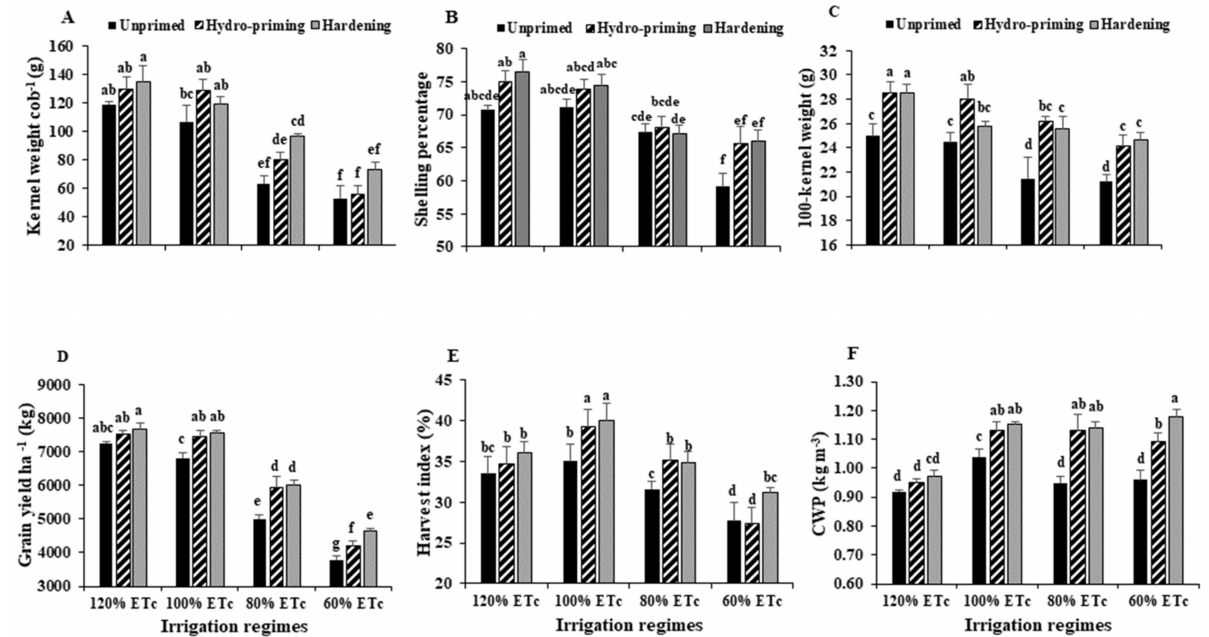
Figure 3. Influence of seed priming treatments on kernel weight per cob ( A ), shelling percentage ( B ), 100-kernel weight ( C ), grain yield ( D ), harvest index ( E ) and crop water productivity ( F ) of maize grown under four irrigation regimes averaged over two growing seasons (2019 and 2020). The bars on the top of the columns represent the SE, and different letters on the column differ significantly by LSD ( p <